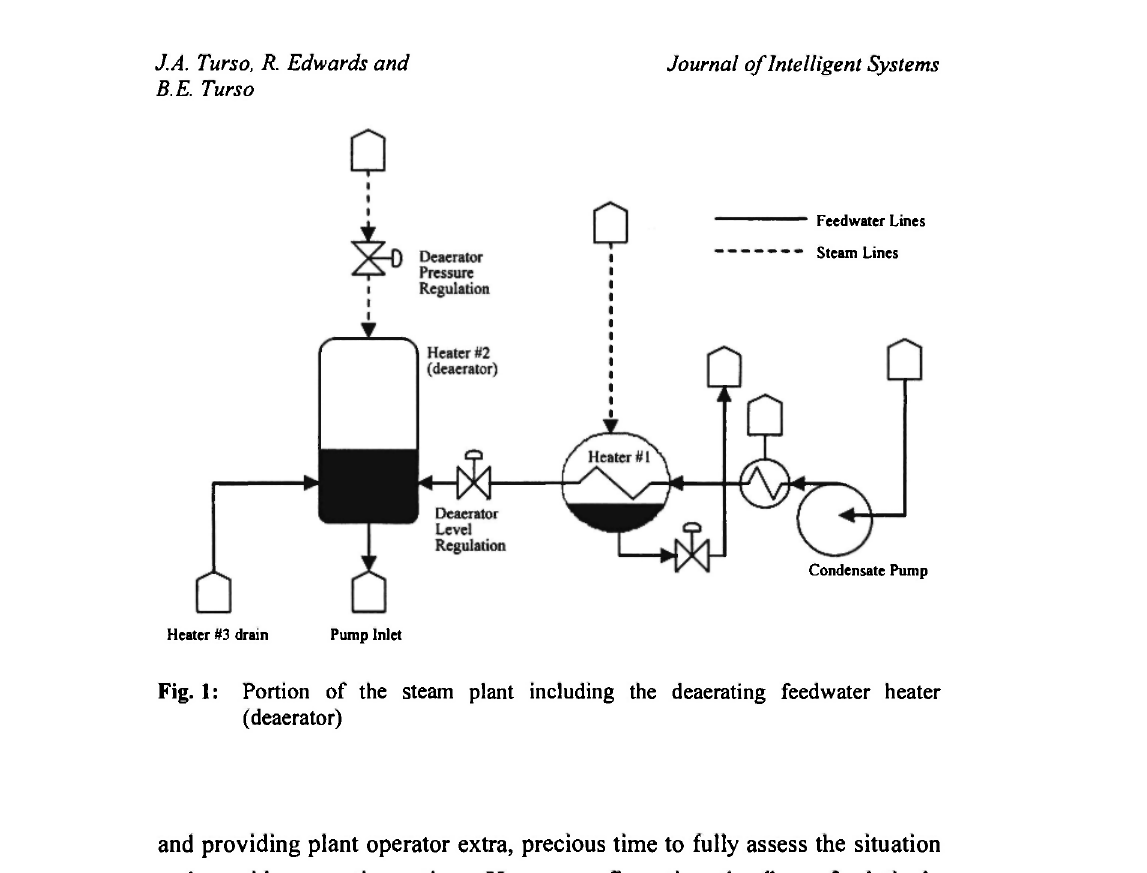
Fig. 1: Portion of the steam plant including the deaerating feedwater heater